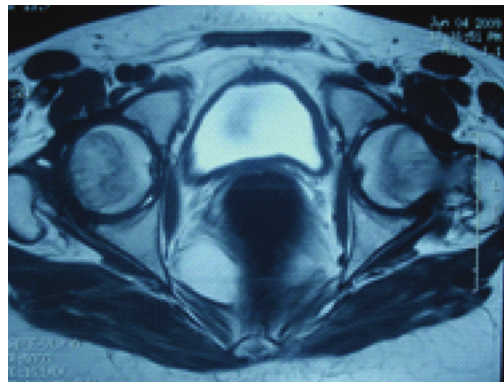
Figure 3: Magnetic resonance imaging (MRI): axial plane cut showing bladder and rectum without interposition of uterus.